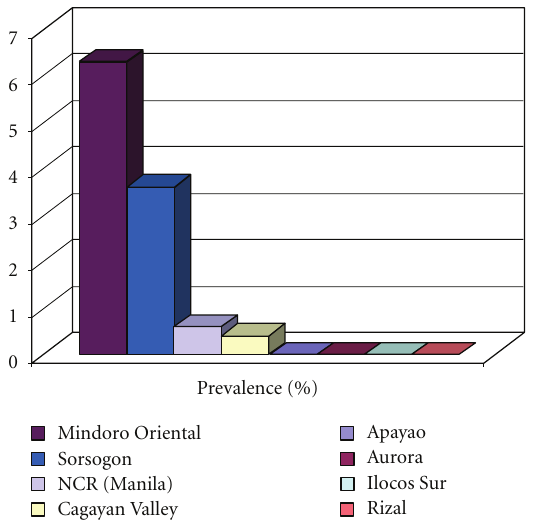
Table 1: Prevalence of other helminthic infections in Luzon and Maguindanao, 2007 and